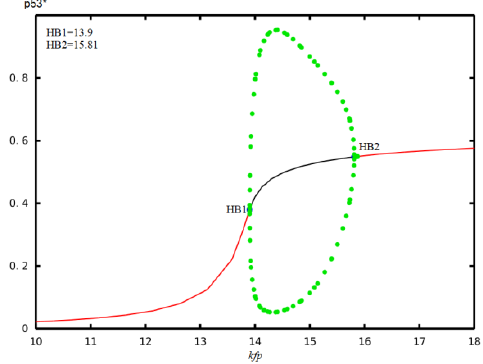
Figure 9. The bifurcation diagram of p53* concentration corresponds to the parameter k fp .